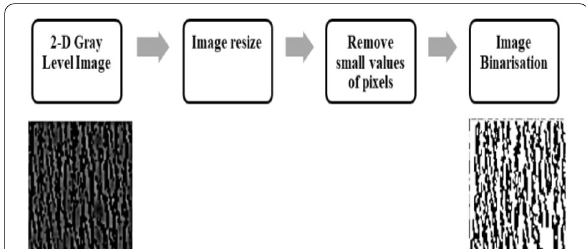
Figure 3 Find the ROI